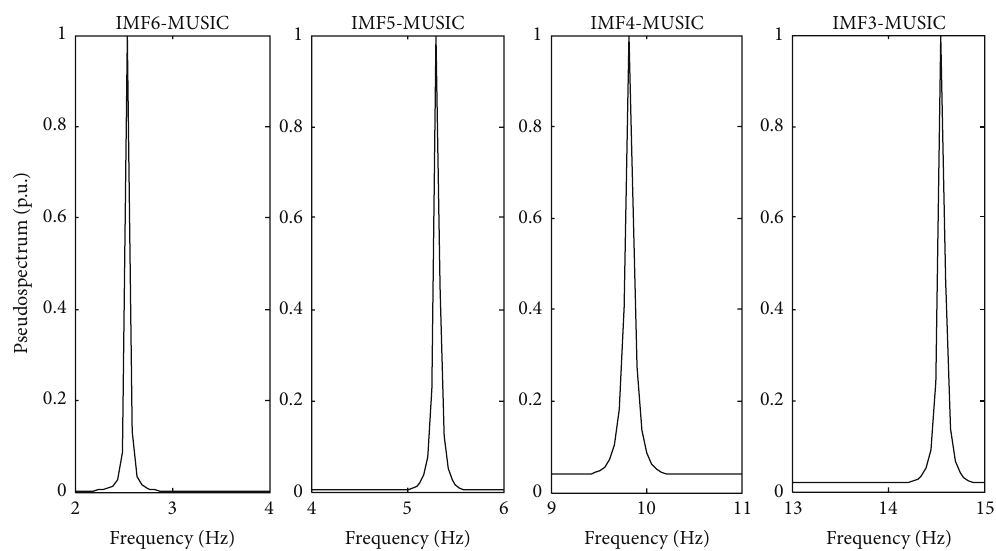
Figure 12: Pseudospectra of different analyzed IMFs.